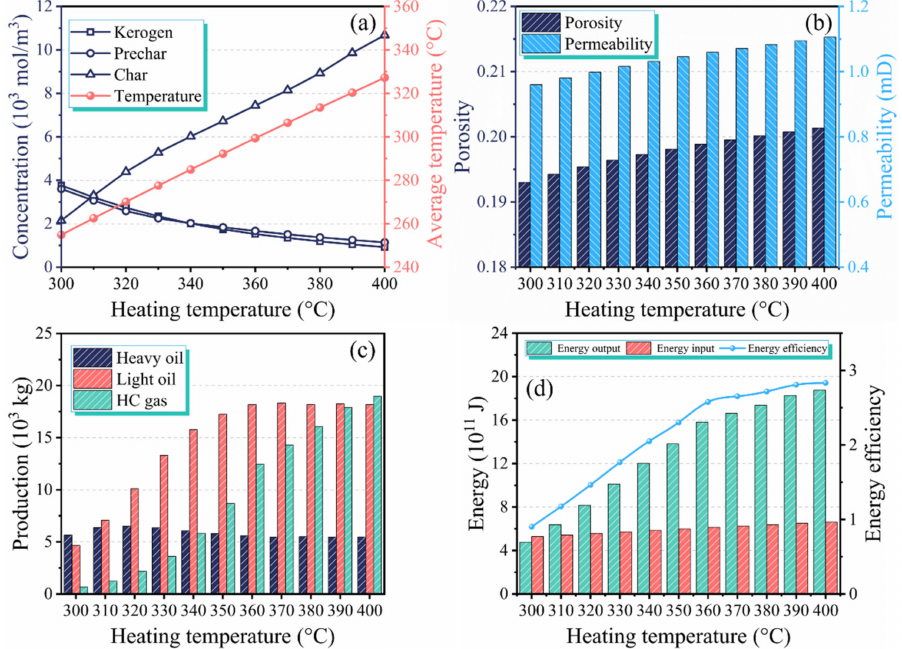
Figure 6. Effect of heating temperature on: ( a ) average reservoir temperature and concentration of solid matter; ( b ) average porosity and permeability; ( c ) cumulative production of oil and gas products; ( d ) cumulative input energy, output energy and energy